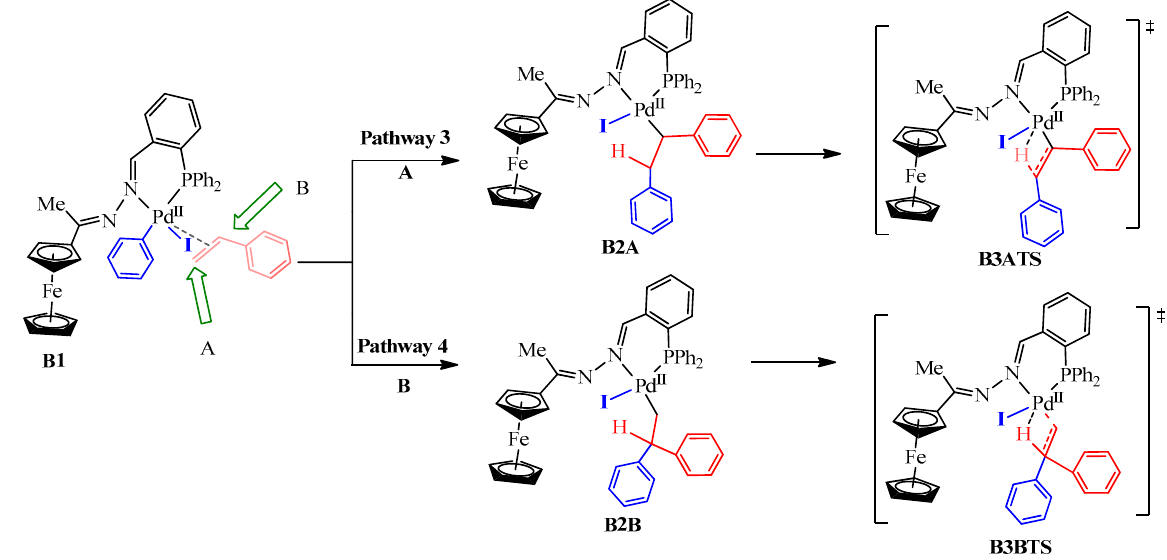
Figure 19. DFT/MO6 optimized geometries of A2 and OA2 , β = N ‐ Pd ‐ P angle and bond distance around the palladium centre. Hydrogen atoms omitted for clarity. Hydrogen atoms have been removed.